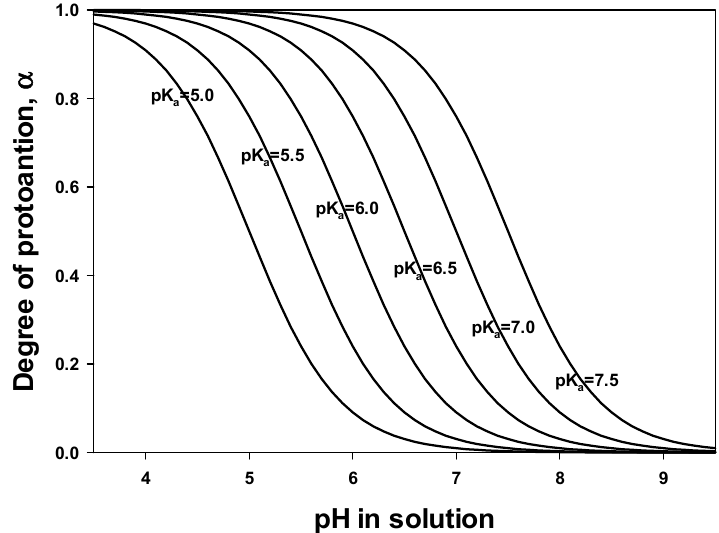
Figure 2. Degree of protonation ( α ) of chitosan as a function of pH and pK a .